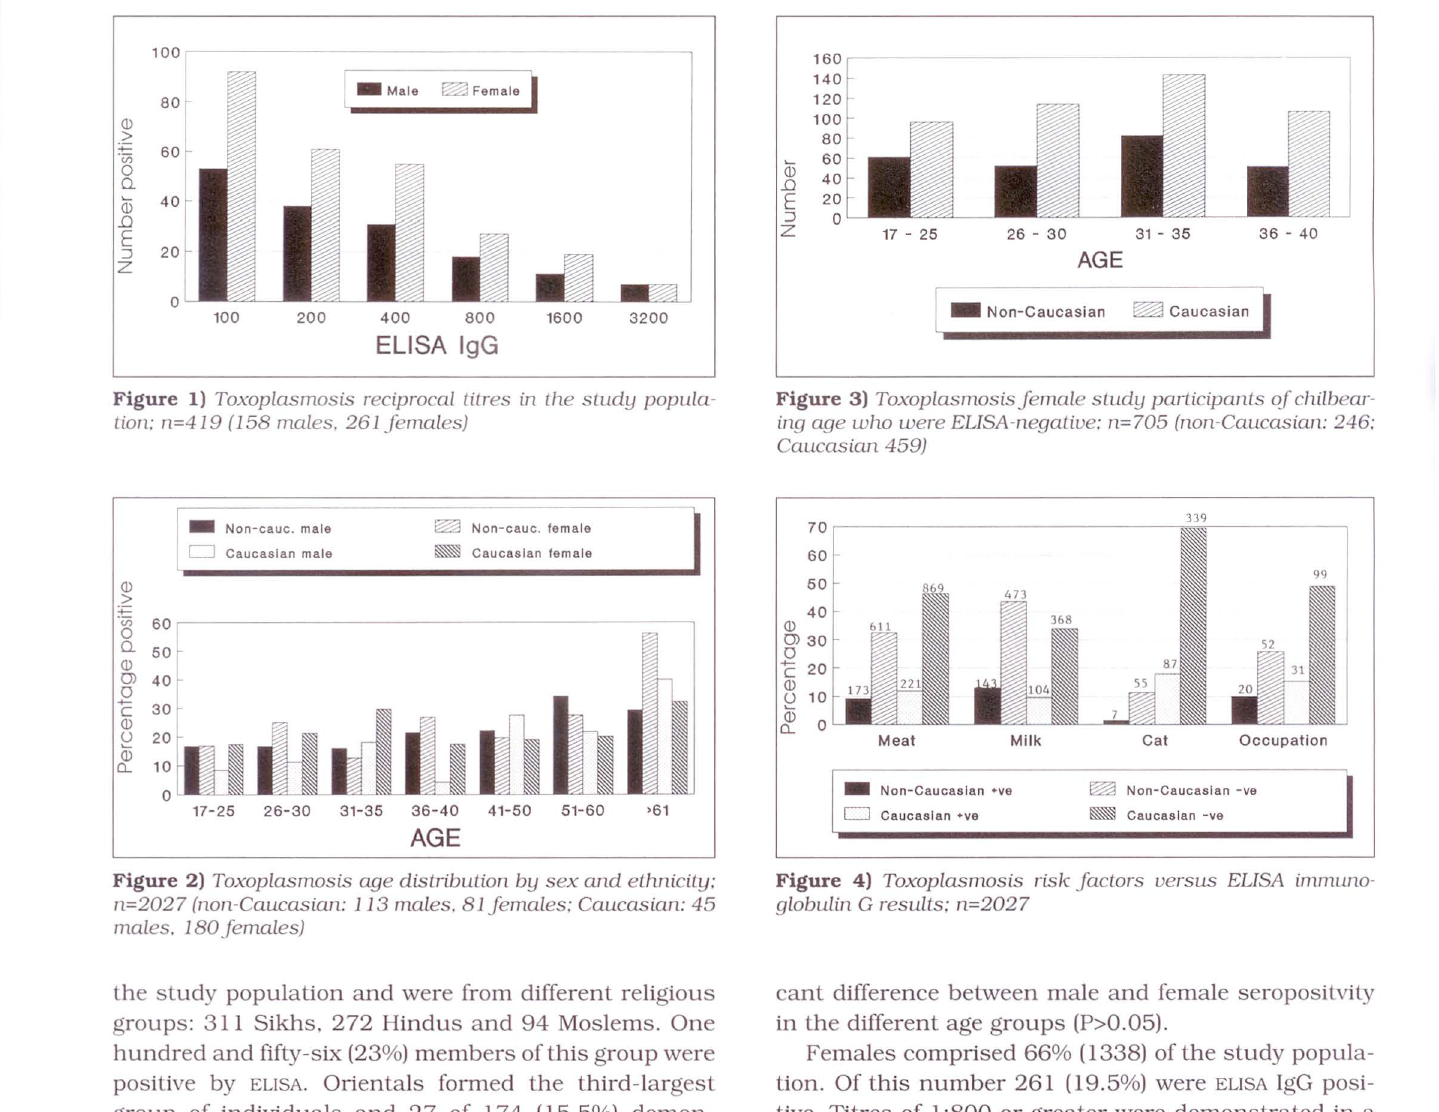
Figure 4) Toxoplasmosis risk factors versus ELISA immuno globulin G results; n=2027 cant difference between male and female seropositvily in the different age groups